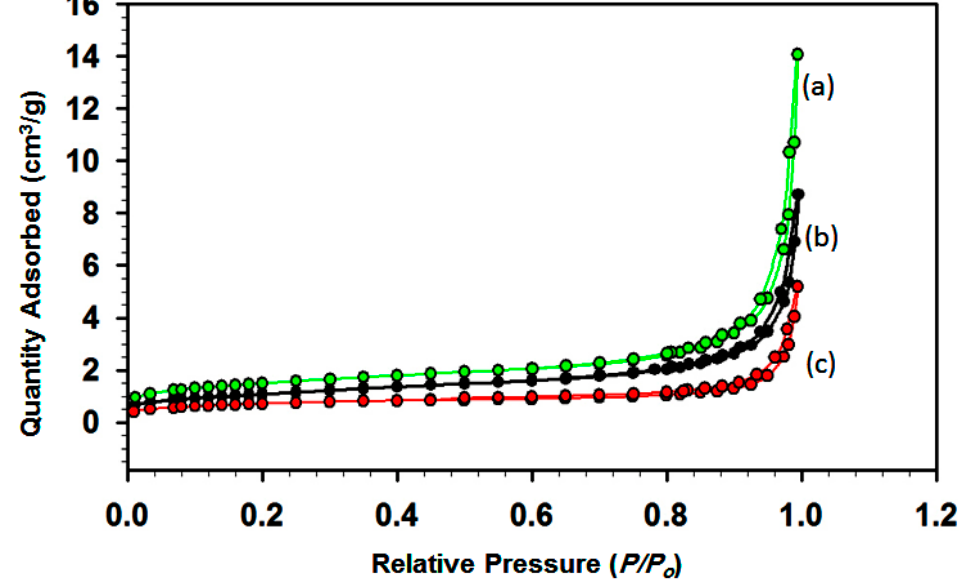
Figure 7. N 2 isothermic adsorption–desorption of as-synthesized samples: ( a ) LC-1, ( b ) LC-2, and ( c ) LC-3.